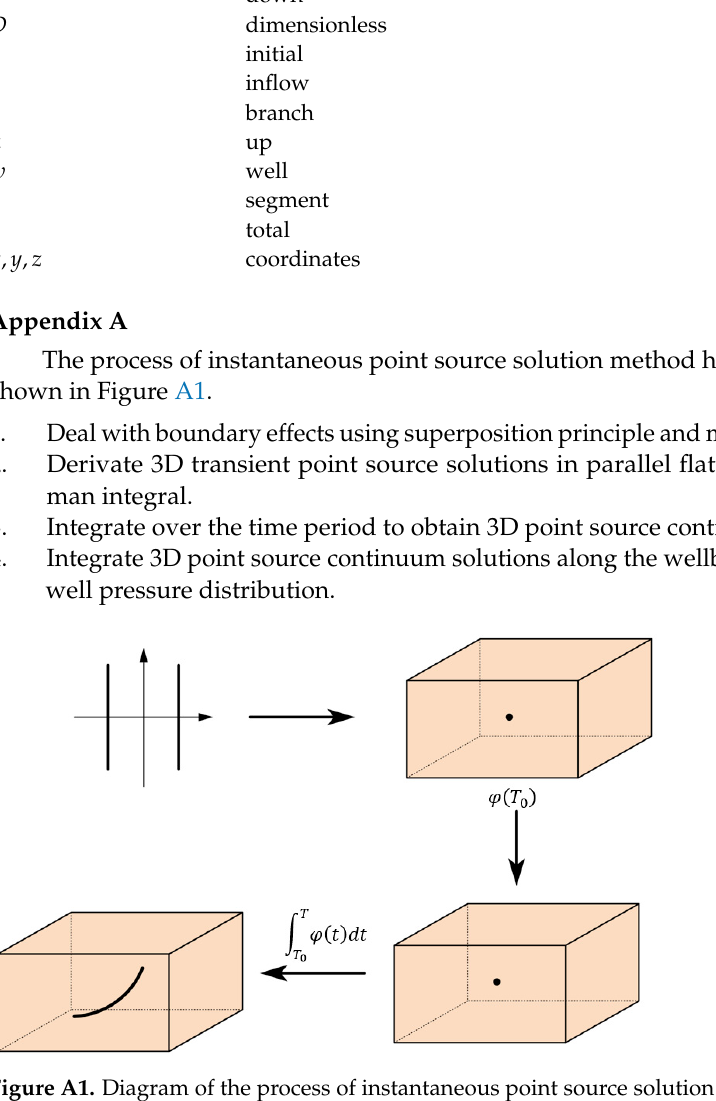
Figure A1. Diagram of the process of instantaneous point source solution method.